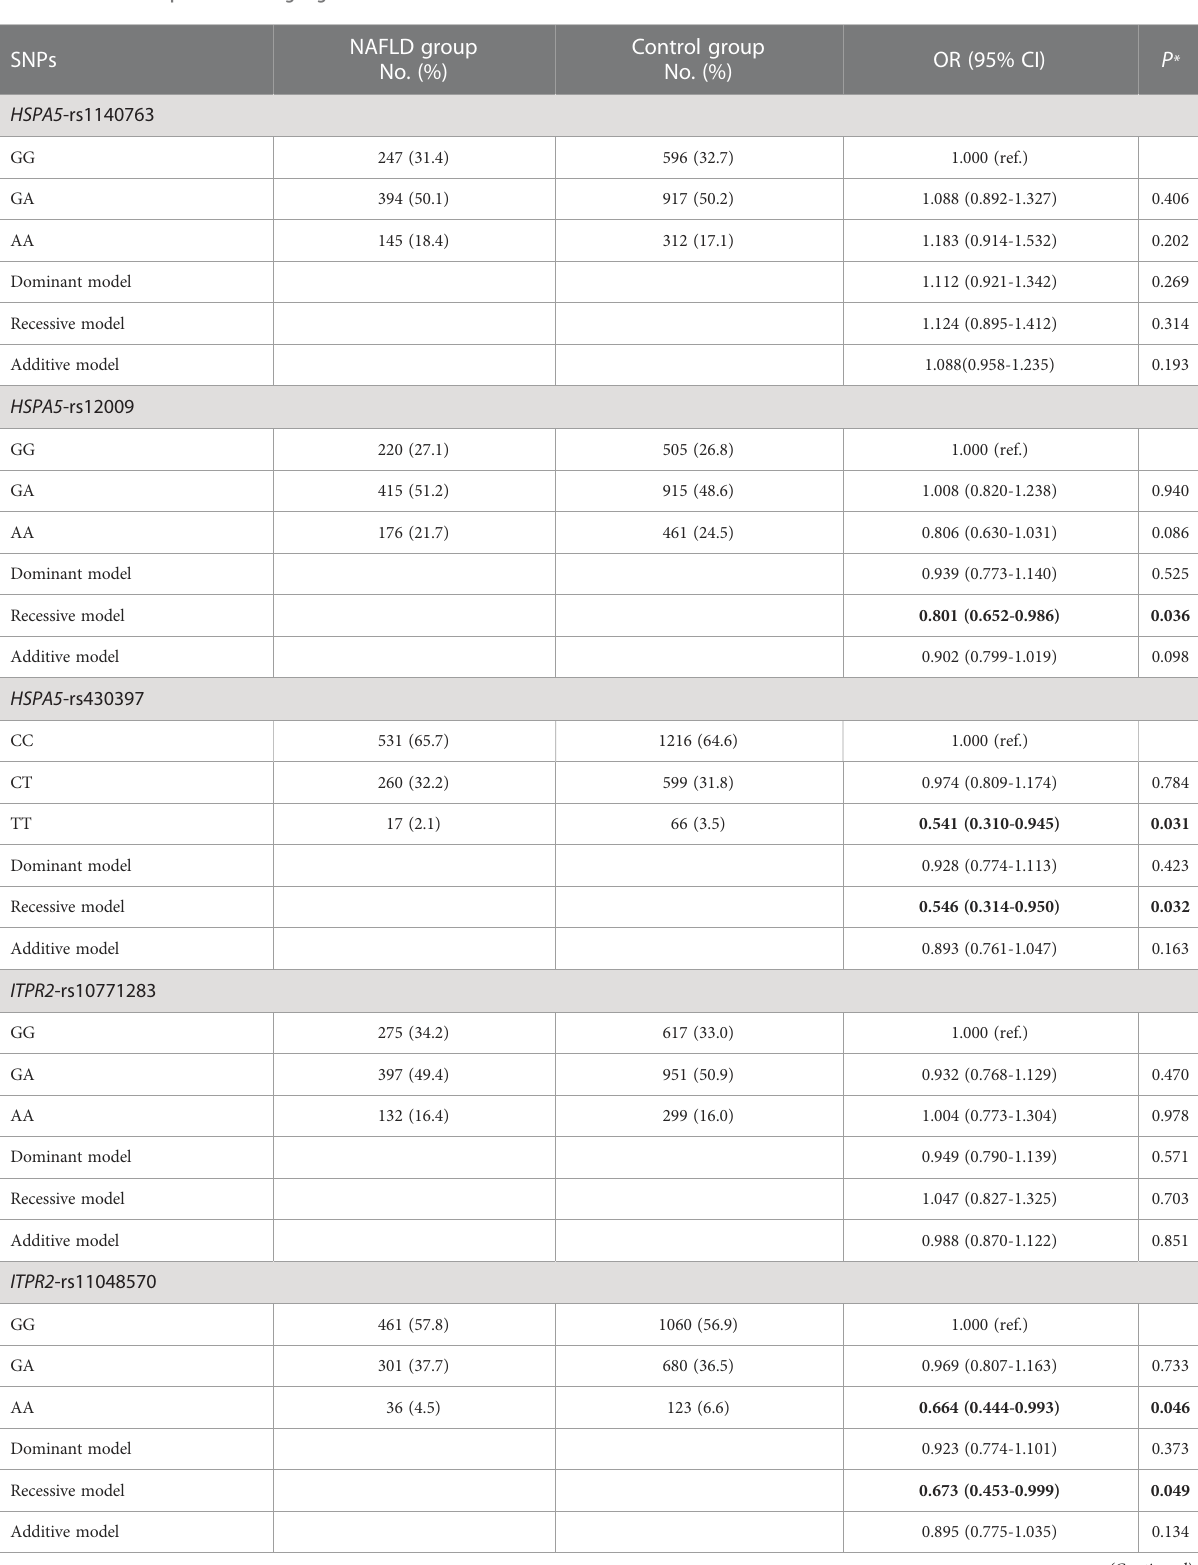
TABLE 2 Relationship between target gene SNPs and